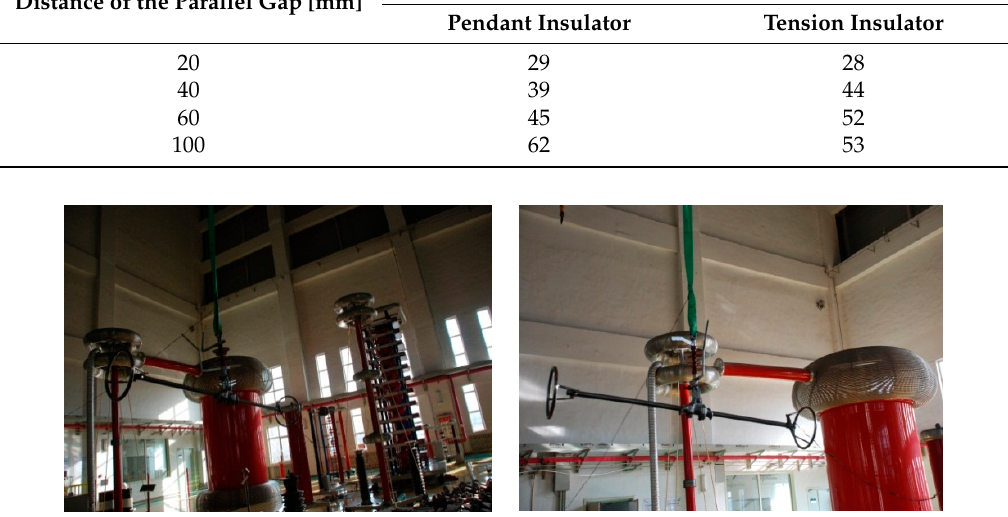
Table 2. Test results of the power frequency discharge voltage of ground wire insulator discharge clearance.